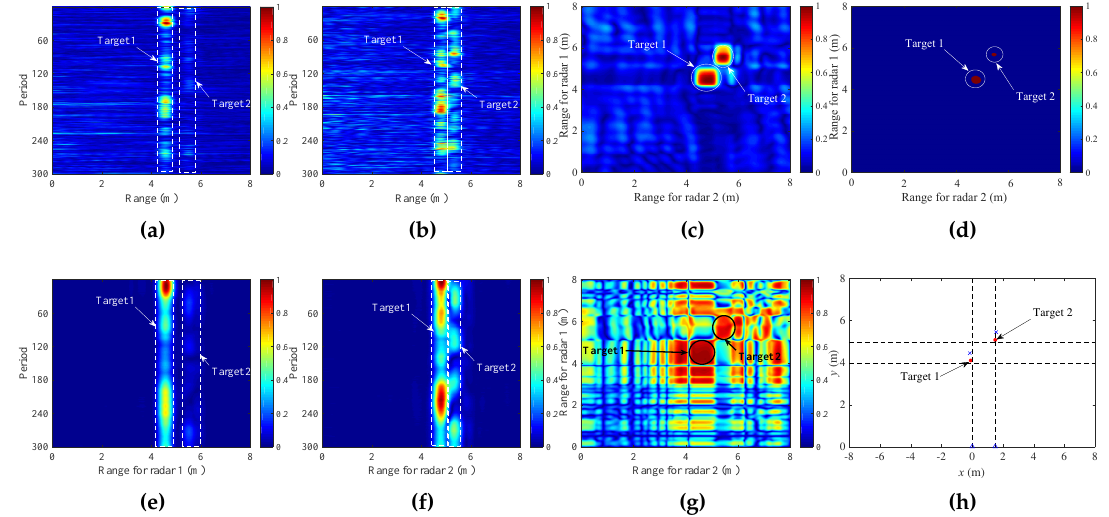
Figure 6. Results of Experiment 1.1: ( a ) range profile plane of two-pulse cancellation for Radar 1; ( b ) range profile plane of two-pulse cancellation for Radar 2; ( c ) cross-correlation result between ( a , b ); ( d ) CFAR detection result; ( e ) range profile plane of average cancellation for Radar 1; ( f ) range profile plane of average cancellation for Radar 2; ( g ) cross-correlation result between ( e , f ); and ( h ) localization result.